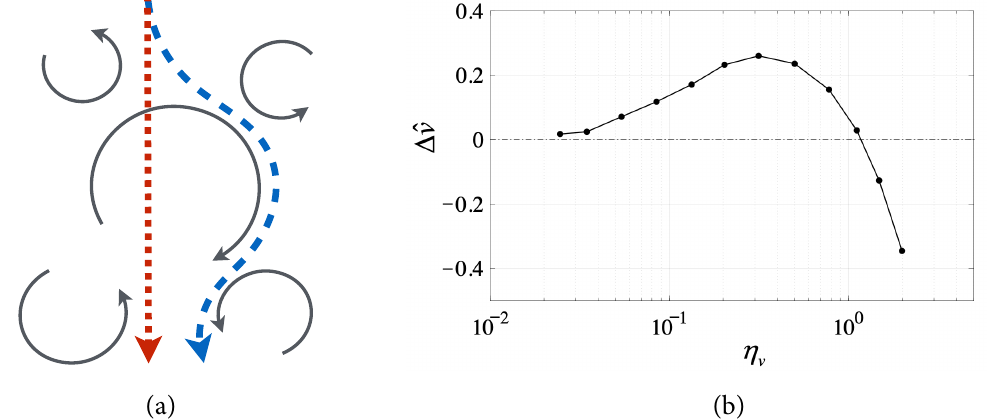
Figure 1. ( a ) Particles are swept and, thus, readily accelerated into the downward sweeping sides of eddies (blue trajectory) rather than falling straight through turbulence (red trajectory). As a result, ( b ) water droplets in turbulent air experience increased settling velocity ( settling parameter ( η v ) is of order one (experimental data taken from [49]).